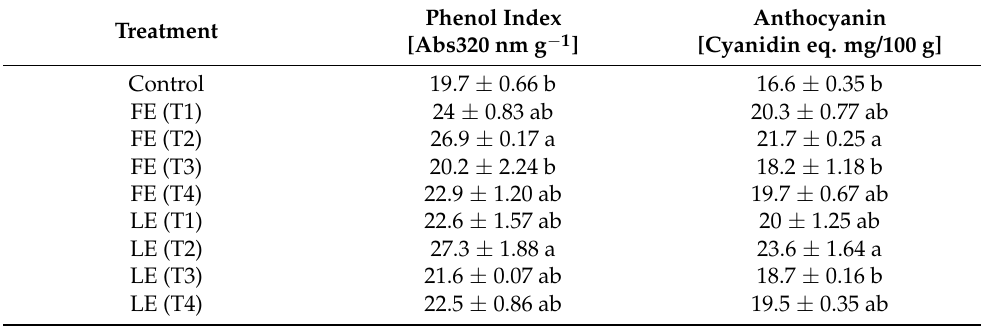
Table 2. Phenol index and anthocyanin content in rocket leaves treated with water (control = C) and with borage extracts (flowers extract = FE or leaves extract = LE) obtained with different maceration times: 1 day (T1), 3 days (T2), 7 days (T3), and 14 days (T4). Values are means ± SE ( n = 3). Data were subjected to one-way ANOVA. Different letters, where present, represent significant differences among treatments. Phenol Treatment